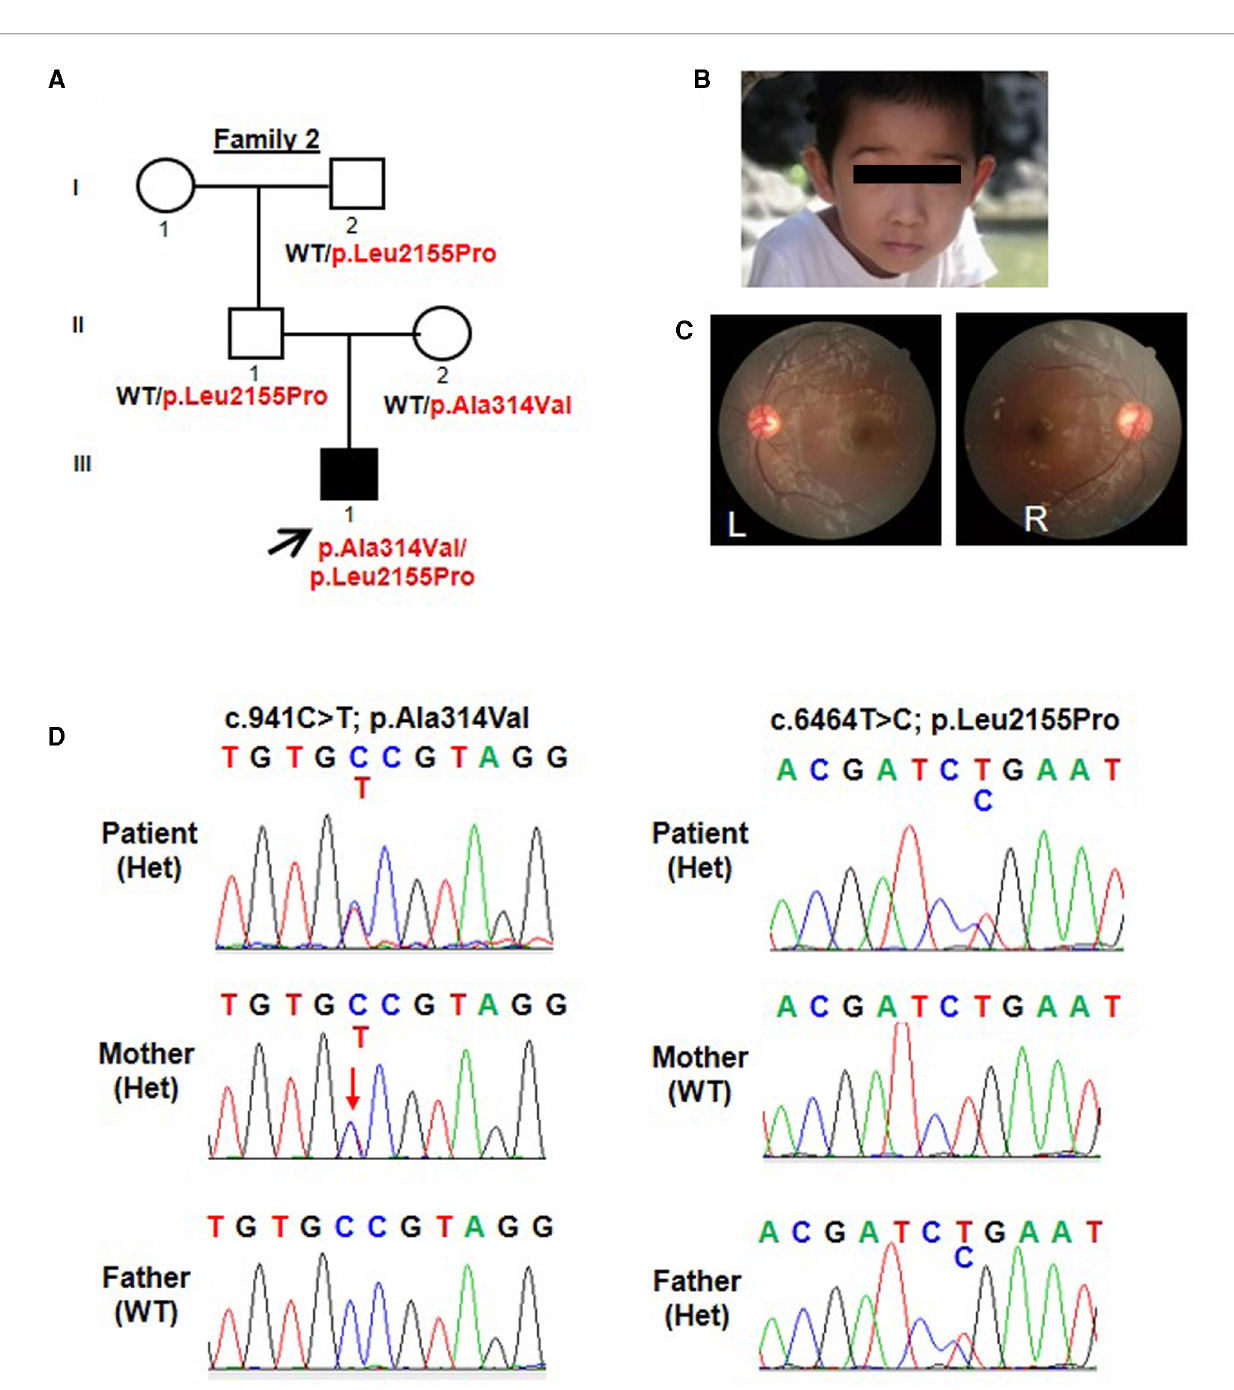
FIGURE 2 Trio-based WES identi fi ed compound heterozygous variants (p.Ala314Val; p.Leu2155Pro) in TENM3 in a patient with speech delay and motor developmental delay. ( A ) Pedigree and genotype information on members of family 2. Squares indicate males, circles indicate females, fi lled symbols indicate affected individuals, and open symbols indicate healthy individuals. Patient 2 is denoted by a black arrow. The proband carried compound heterozygous variants: c.941C>T; p.Ala314Val and c.6464T>C; p.Leu2155Pro. ( B ) Facial picture of the proband at the age of 3 years old with resolved esotropia. His prominent and big ears were noted. ( C ) Fundus examination of patient 2 showed no structural anomalies. ( D ) Sequencing chromatograms of the compound heterozygous TENM3 variants (c.941C>T; p.Ala314Val and c.6464T>C; p.Leu2155Pro) in patient 2 and the parents. WT, wild type; Het,